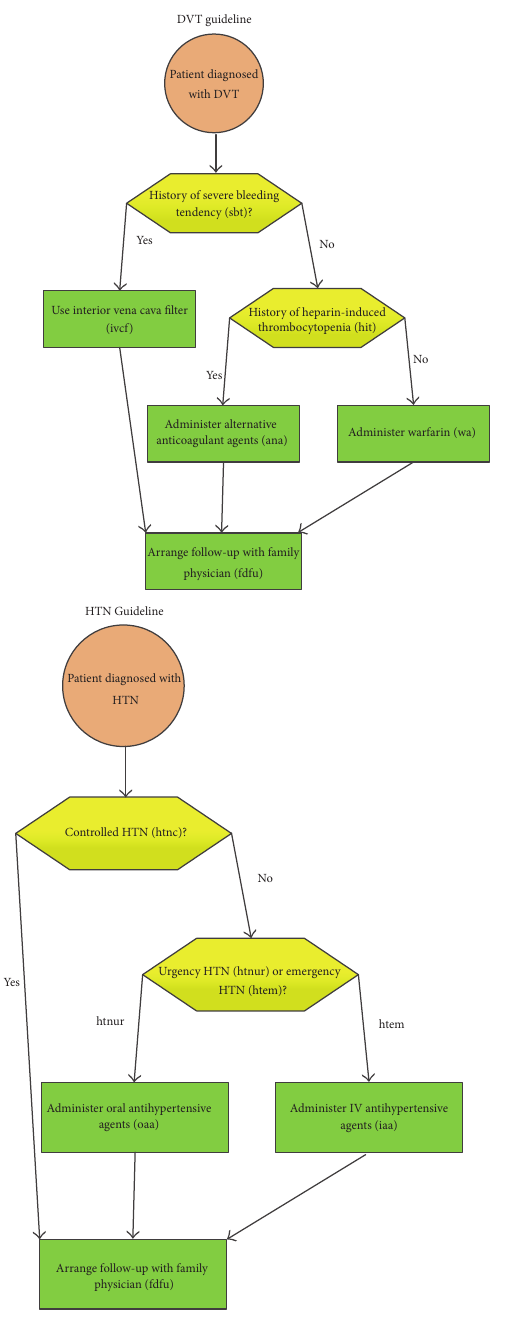
Figure 6: Clinical guidelines for HTN and DVT [17].